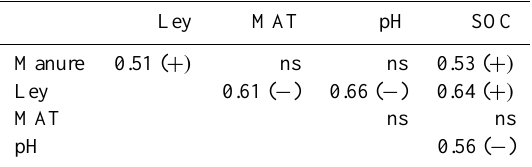
Table 2. Correlation matrix showing rank correlation coefficient ( R - value) for the different predictors of SOC in each county (averaged over Inventories I–III), with ± indicating the direction of the corre- lation. The selected predictors were: average mass of manure pro- duced and potential application rate [Mgha − 1 yr − 1 ], ley as a pro- portion of total agricultural area [%], the condensed climate variable r e and average soil pH. MAT = mean annual